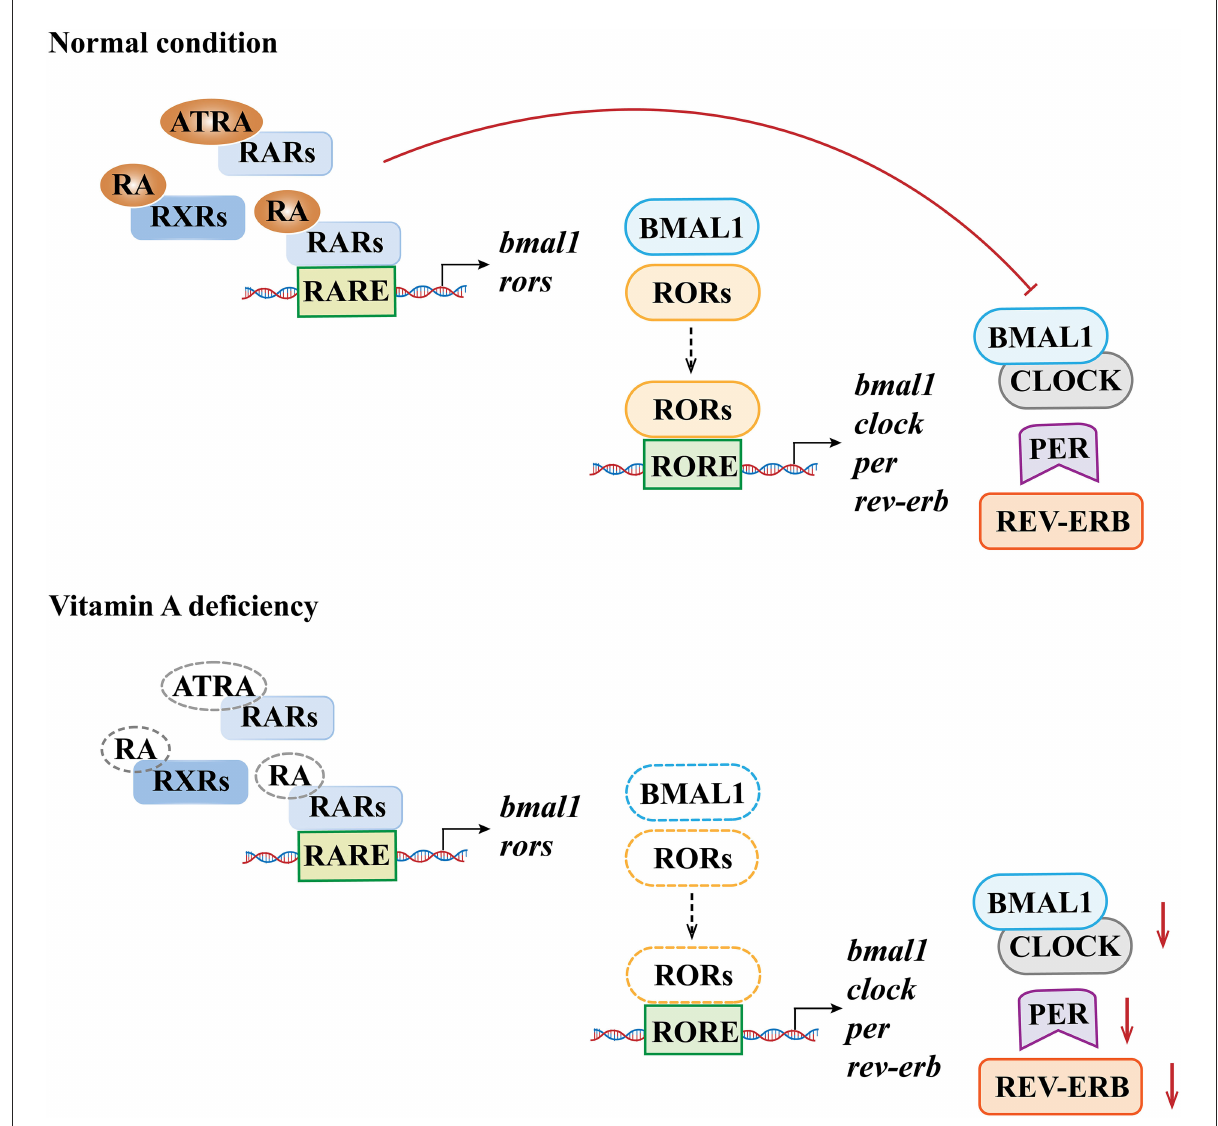
FIGURE3 Molecular mechanisms underlying the effects of vitamin A deficiency on biological rhythm molecules. The dotted line denotes the lack of the